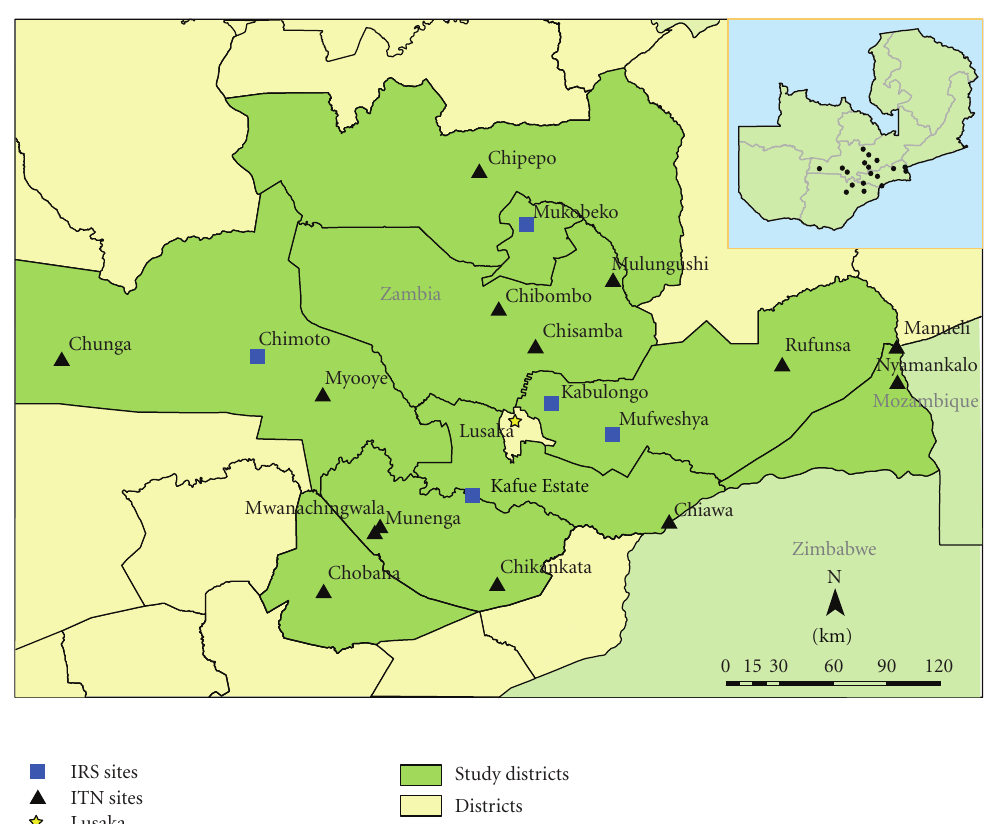
Figure 1: Map of Zambia showing the location and spatial distribution of GIS-based decision support system monitoring sentinel sites.